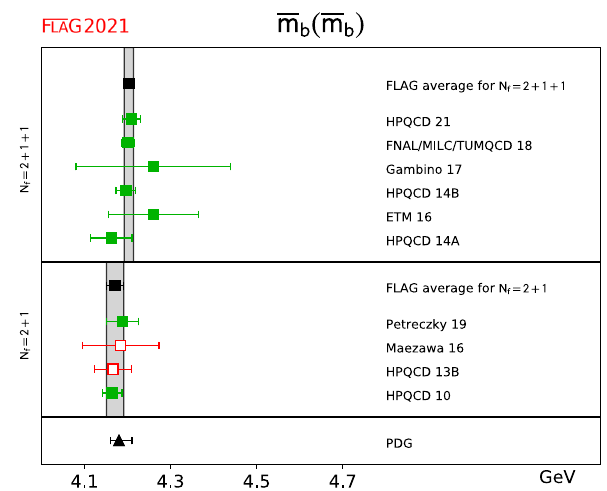
Fig. 7 The b -quark mass for N f = 2 + 1 and 2 + 1 + 1 flavours. The updated PDG value from Ref. [165] is reported for comparison